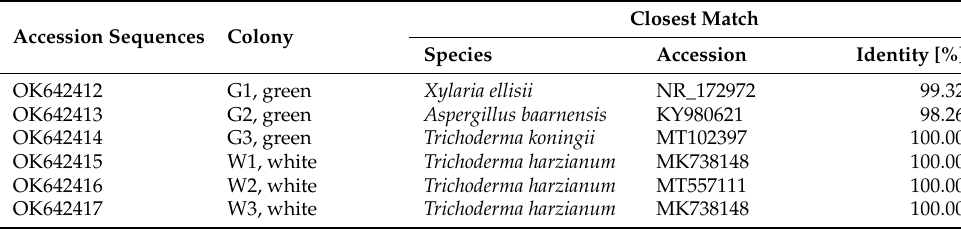
Table 2. Top BLAST match of six isolates to sequences in GenBank The colony name for the samples (G1–G3, W1–W3) are the same as those used in Table